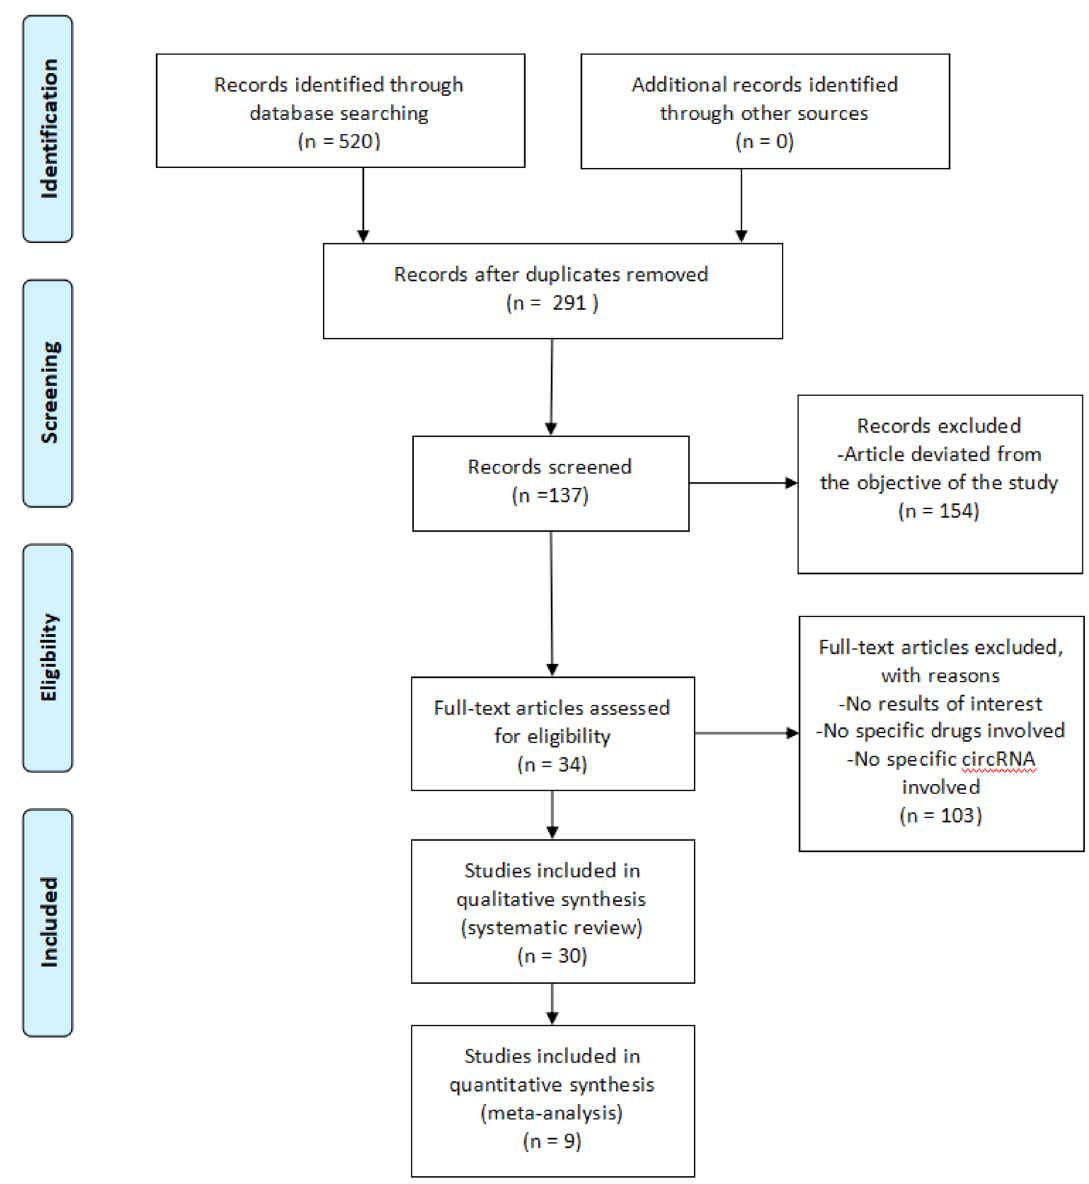
Figure 1. Flowchart of trial